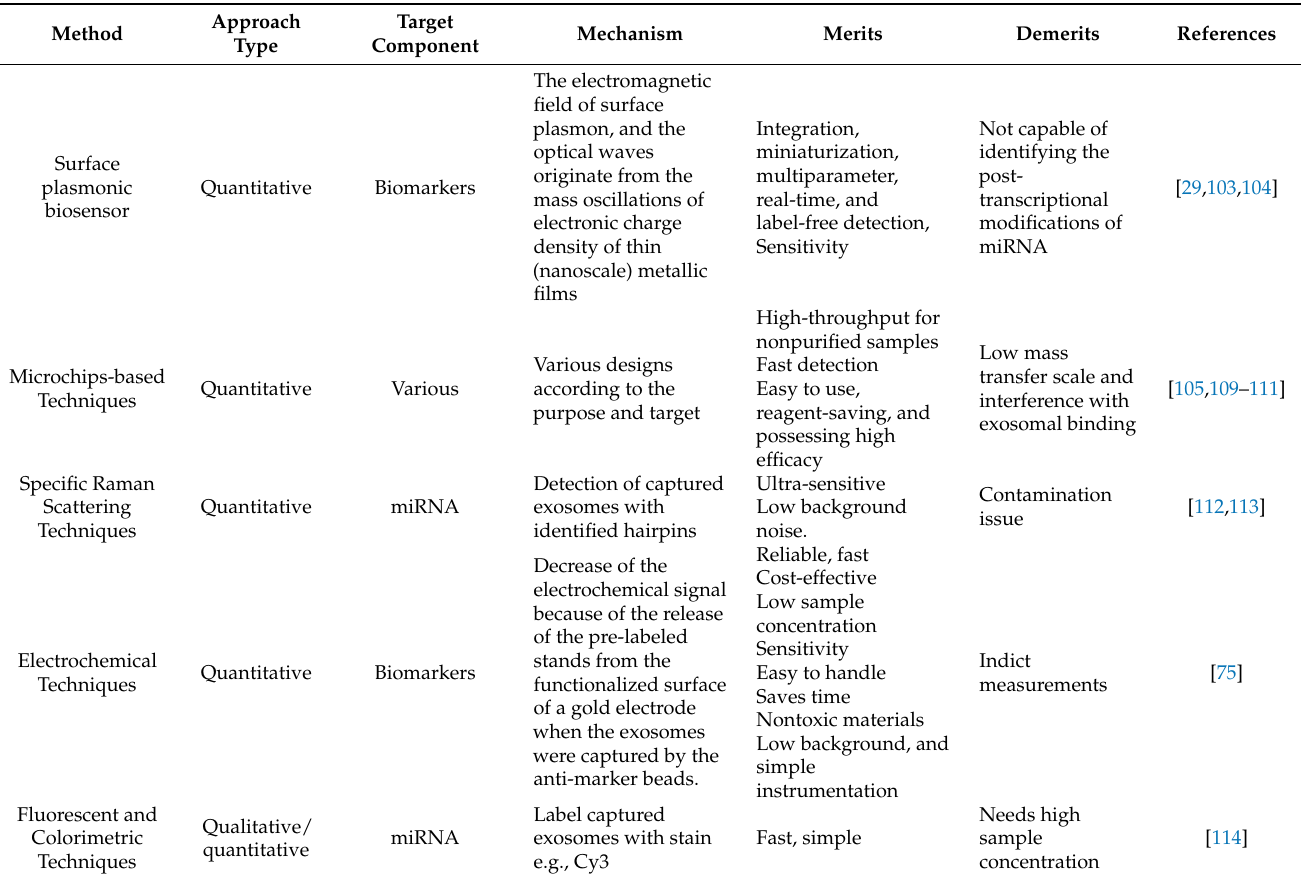
Table 3. Detection techniques for exosomal